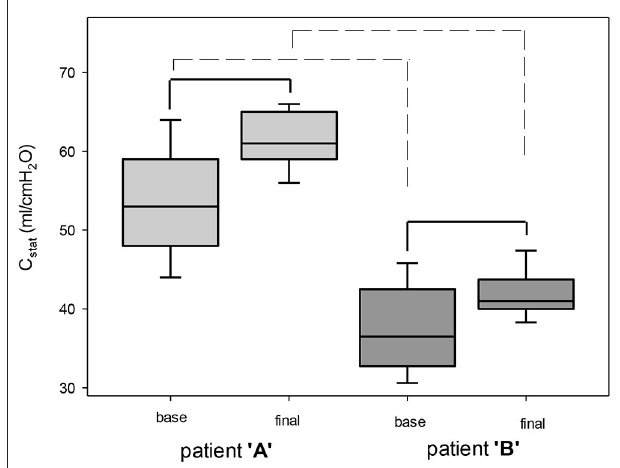
FIGURE 2 | Compliance at baseline and following positive end-expiratory pressure (PEEP) trial. C stat , compliance. Solid line, significant difference within a patient. Dashed line, significant difference between patients. Box plots represent mean, ± SD and 5 th -95 th percentile, p < 0.05.